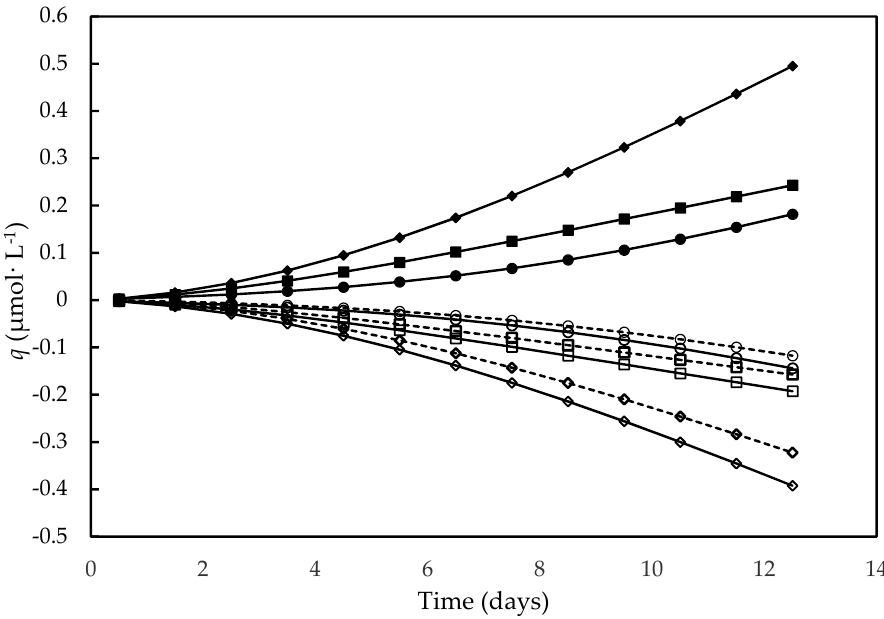
Figure 5. Development of O 2 (full symbols), consumption of H + (open symbols, continuous line) and H 2 O variation (open symbols, dashed line) over time in different culture media. F/2 medium ( , ), Bold’s Basal medium ( , • ), Alternative medium ( , (cid:117) ).